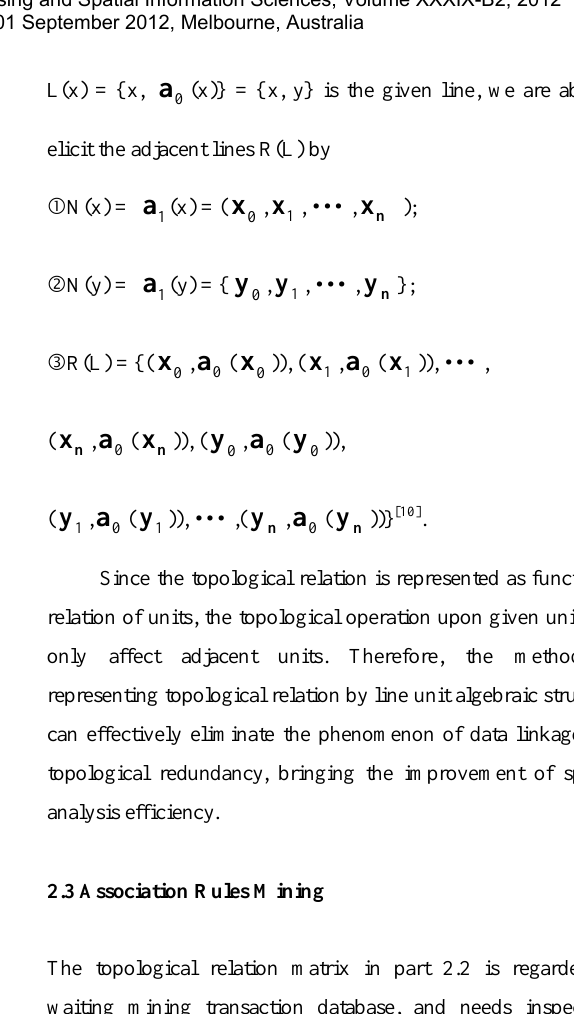
Figure 3. Sample line graphic